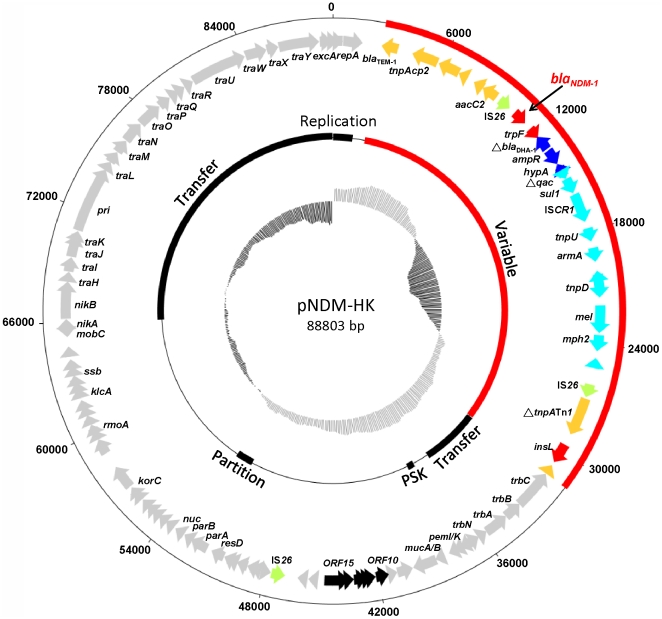
An overview of the bla
NDM-1 encoding plasmid, pNDM-HK.Starting from the outside, the first circle indicates the coordinate of the complete plasmid circle and the 28.9 kb variable region is showed in red. The open reading frames (ORFs) were annotated in the second circle with arrows representing the direction of transcription. Coding sequences with and without pEL60 homologs are indicated in grey and black, respectively. All IS26 elements are indicated in green. The variable resistant region is coded by the same color scheme as in figure 2. The third circle indicates the functional sequence blocks. The G+C plot is indicated in the inner circle (mean 51.5%), ranging from high (grey) to low (black).